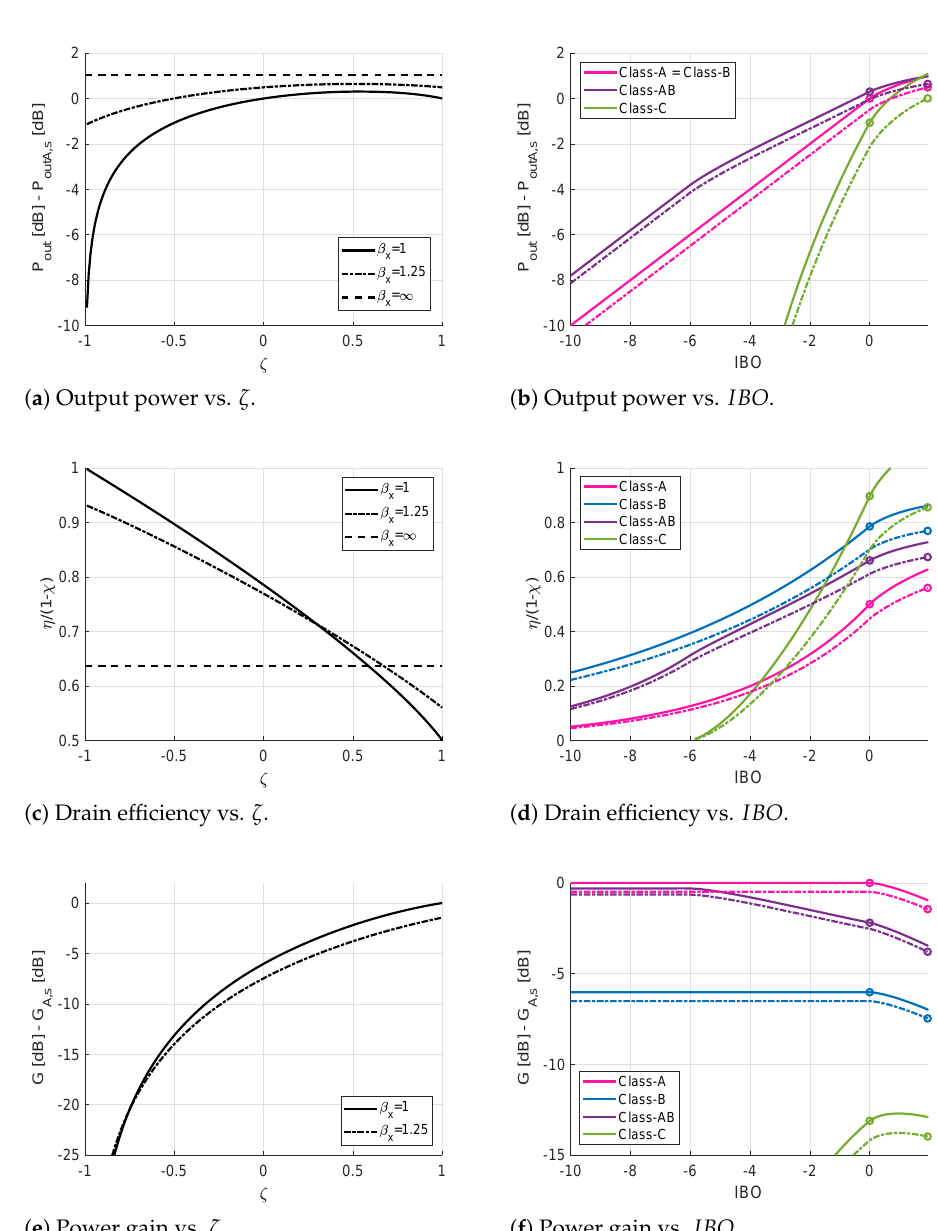
Figure 15. Saturated ( β x = 1, solid lines) vs. over-driven ( β x > 1, dashed lines) PA performance. Circles in the right plots represent the maximum operating